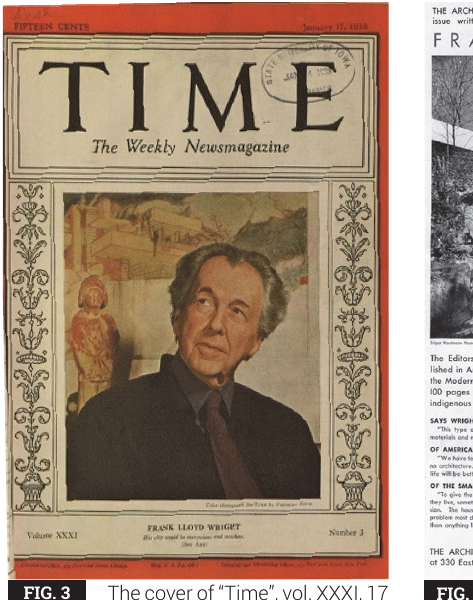
FIG. 5 The cover of “Time”, vol. XXXI, 17 January 1938, No.